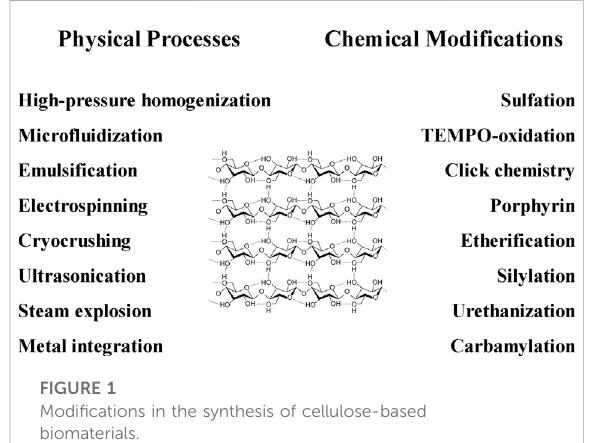
FIGURE 1 Modi fi cations in the synthesis of cellulose-based